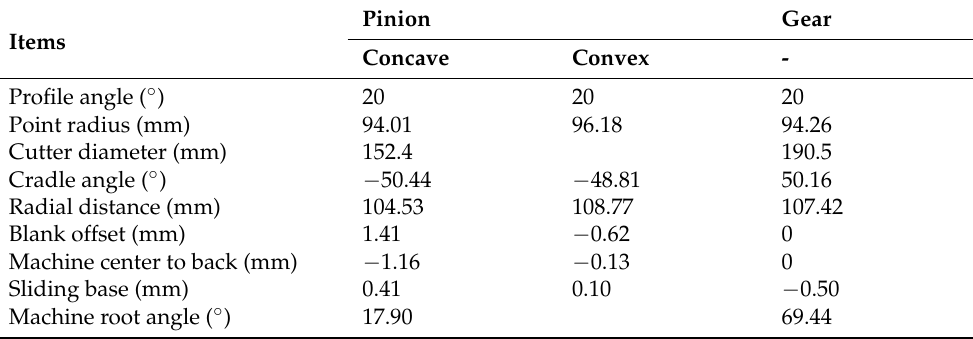
Table 2. Machine-tool settings.